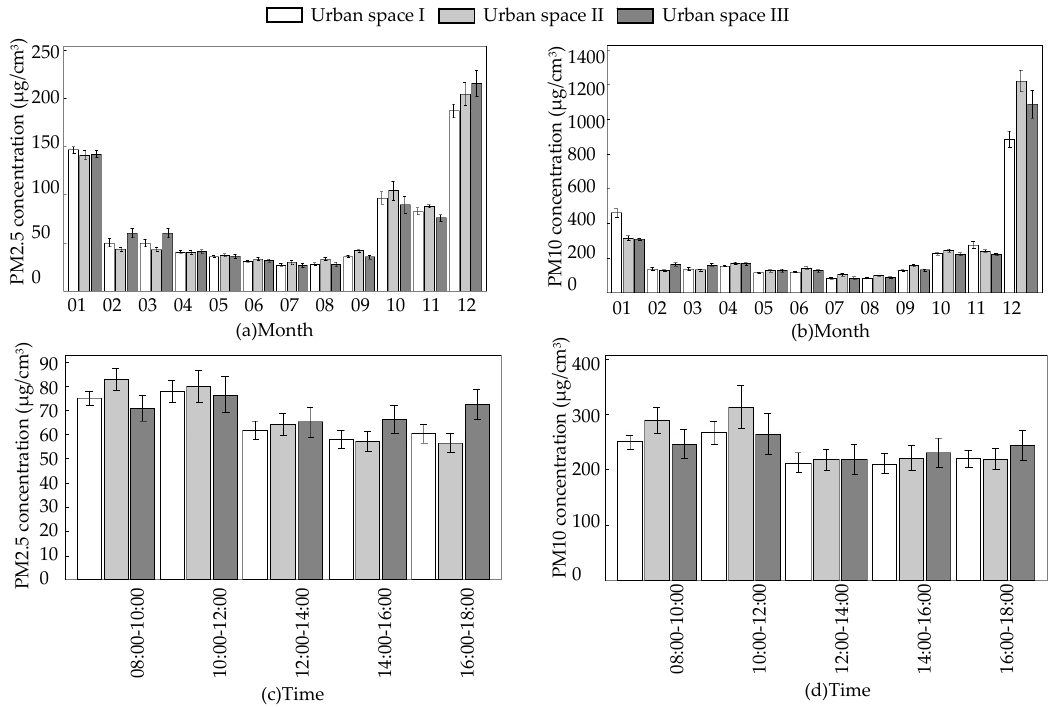
Figure 3. The relationship between time factors and PM concentration. ( a ) The relationship between month and PM2.5 concentration; ( b ) the relationship between month and PM10 concentration; ( c ) the relationship between time and PM2.5 concentration; ( d ) the relationship between time and PM10 concentration.